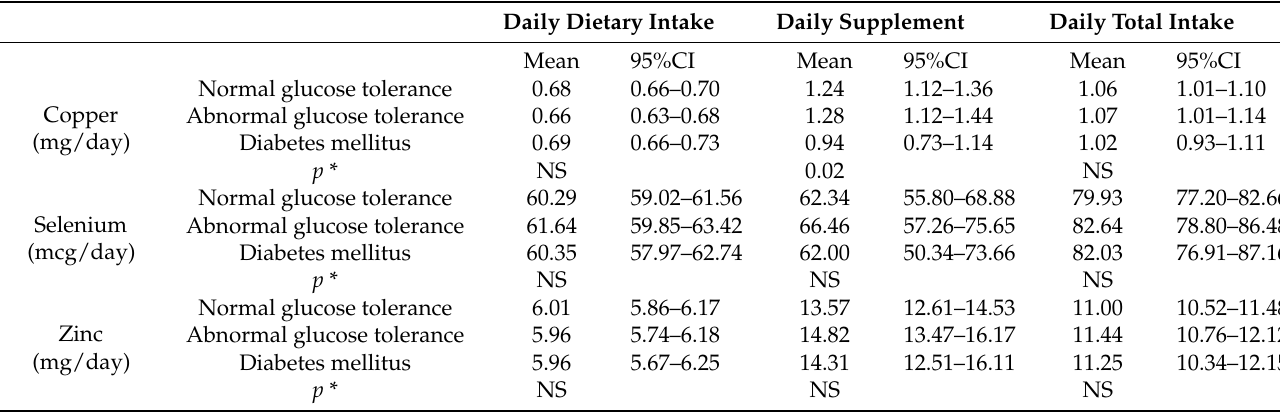
Table 2. Daily dietary intake, daily supplement, and daily total intake of copper, selenium, and zinc by the states of glucose